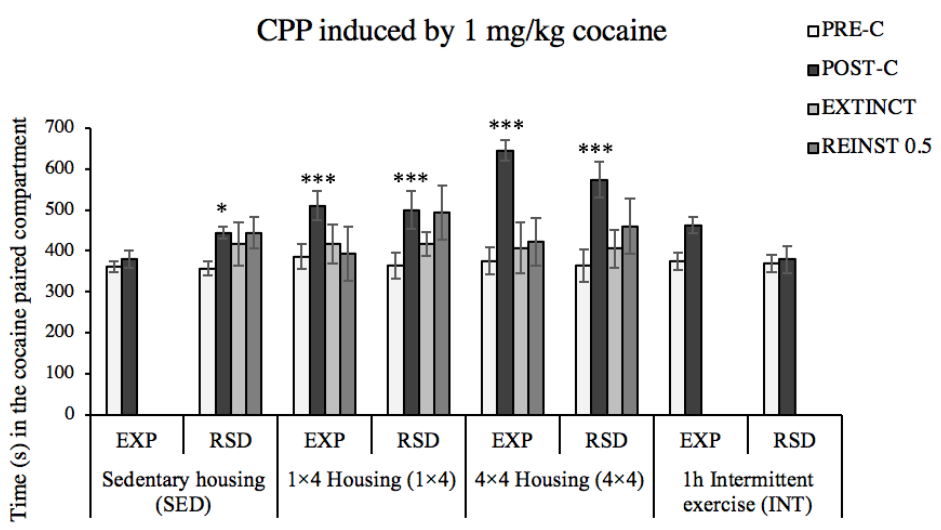
Figure 5. The increase of physical-activity-enhanced cocaine-conditioned rewarding effects. Animals were randomly assigned to the following groups according to their physical activity condition: sedentary housing (SED–EXP n = 12; SED–RSD n = 12); one activity wheel per cage (1 × 4-EXP n = 12; 1 × 4-RSD n = 12); four activity wheels per cage (4 × 4-EXP n = 10; 4 × 4-RSD n = 10); regimen of intermittent exercise (INT–EXP n = 12; INT–RSD n = 12). The bars represent the time (s) spent in the drug-paired compartment before conditioning sessions in the Pre-C test (white bars), and after conditioning sessions in the Post-C test (black bars), in the last extinction session (EXTINCT, light gray bars), and in the reinstatement (REINST) test (dark gray bars). Data are presented as mean values ± SEM. Bonferroni’s test * p < 0.05; *** p < 0.001 significant difference in the time spent in the drug-paired compartment vs. corresponding Pre-C.